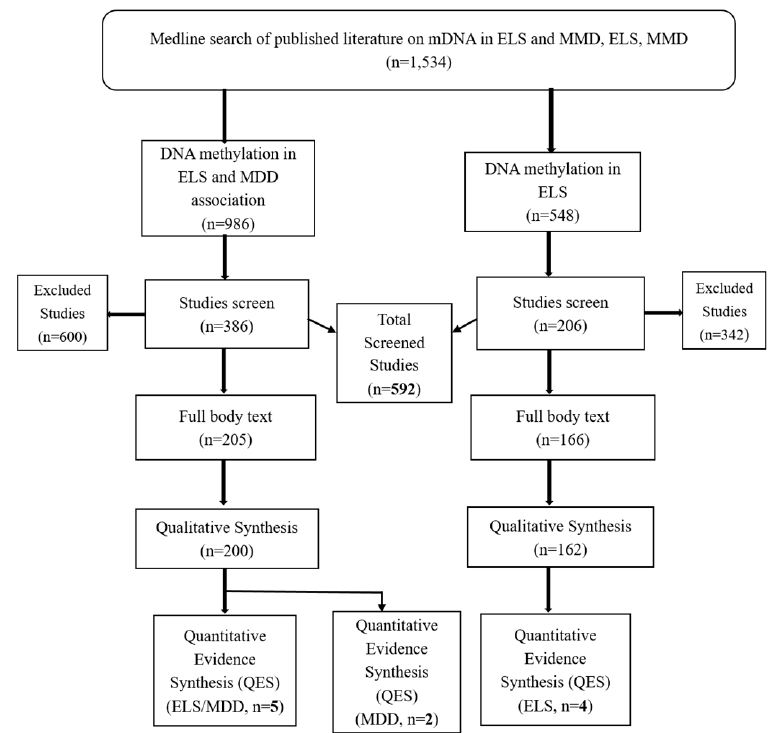
Figure 1. DNA methylation (mDNA) of candidate gene (1F exon of NR3C1 (glucocorticoid receptor) gene) associated with early life stress (ELS) and major depressive disorder (MDD).